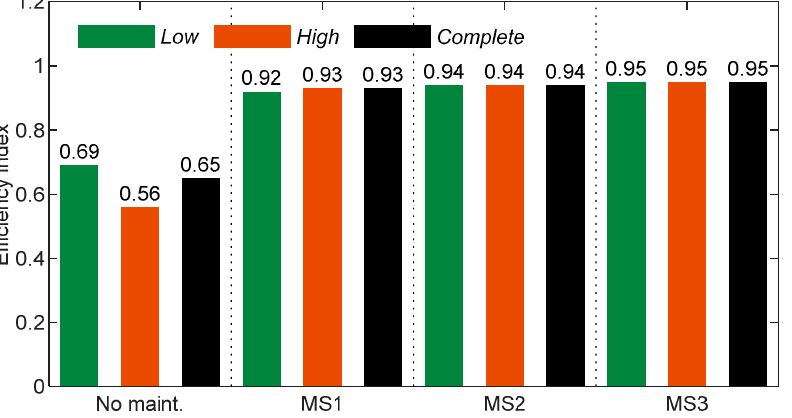
Figure 12. Comparison of the efficiency index for both heights and for the complete sample. Table 3. Comparison of the total number of replacements and maintenance costs for both heights and for the complete sample.